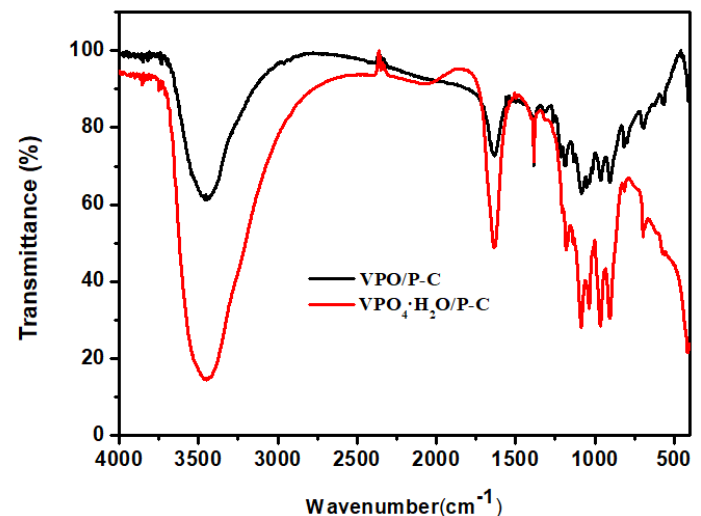
Figure 1. FTIR spectra of VPO 4 ·2H 2 O/P-C and VPO/P-C.